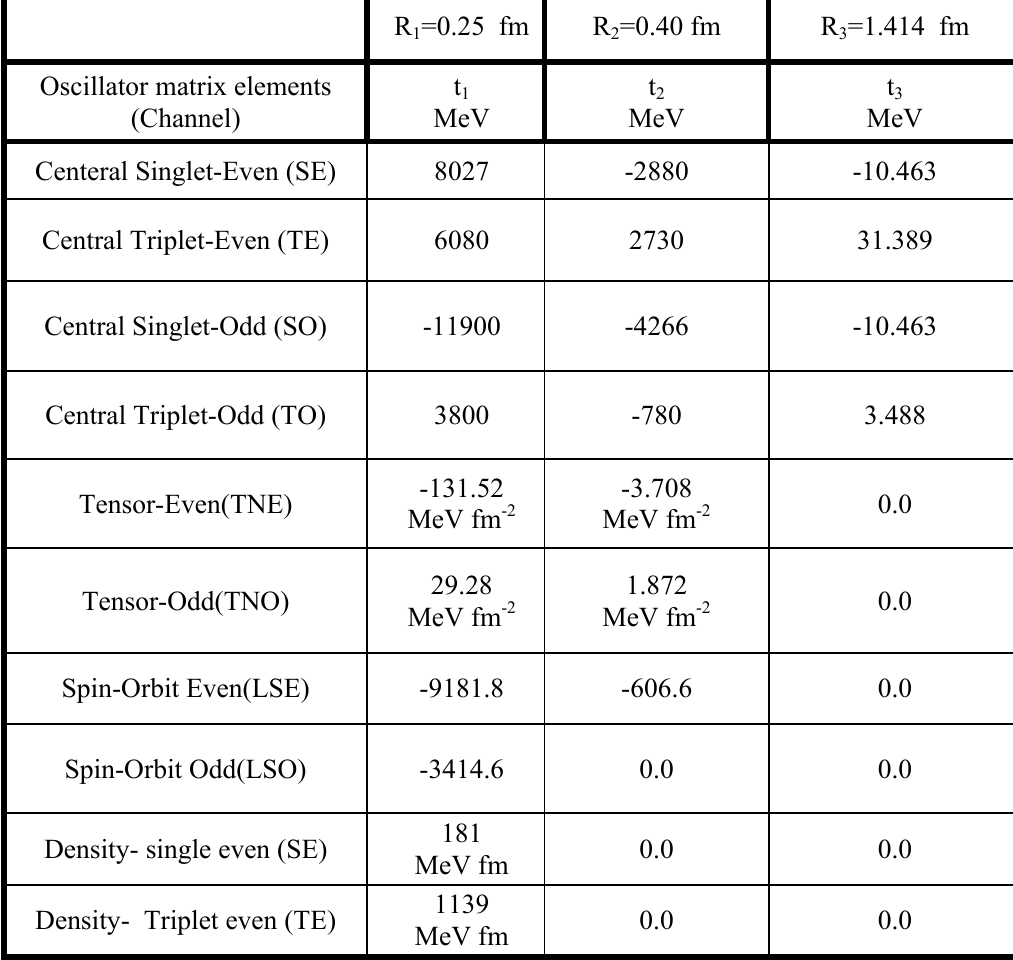
Table 1: The values of the best fit to the potential parameters for M3Y-P2